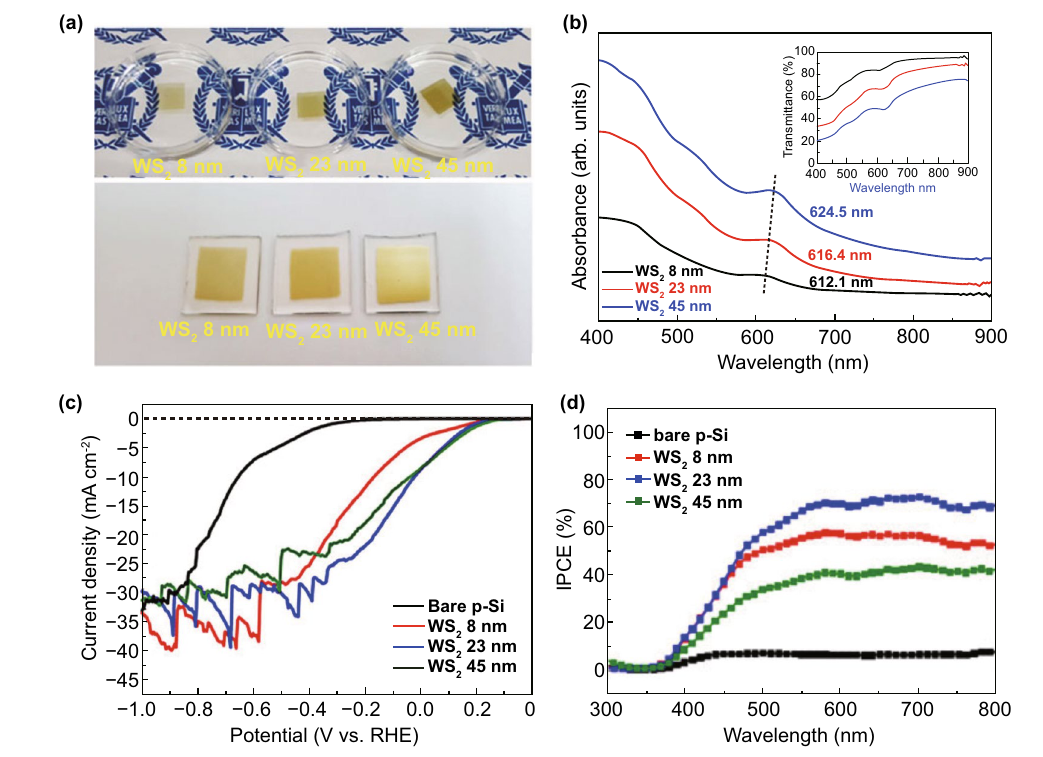
Fig. 18 a Photographs of WS 2 films on glass with different thicknesses. b UV–Vis absorbance of WS 2 different thin films. c PEC performance illustrated as J–V polarization curves for WS 2 different films size. d IPCE measurements of WS 2 different thin films size on p‑Si photo‑cathodes. Adapted with permission from Ref.